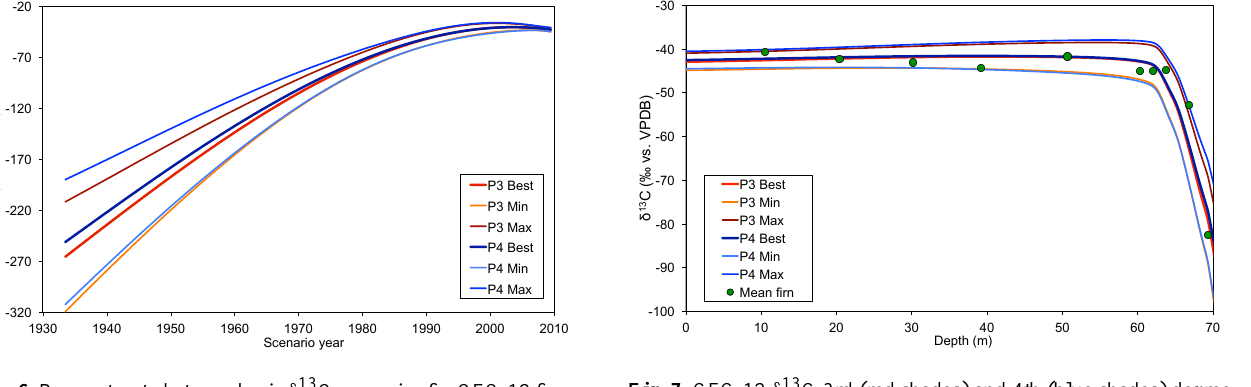
Fig. 6. Reconstructed atmospheric δ 13 C scenarios for CFC-12 from 1933 to 2009; best scenarios, maxima, and minima. P3 (red shades) and P4 (blue shades) indicate 3rd and 4th degree polynomial firn model results, respectively.